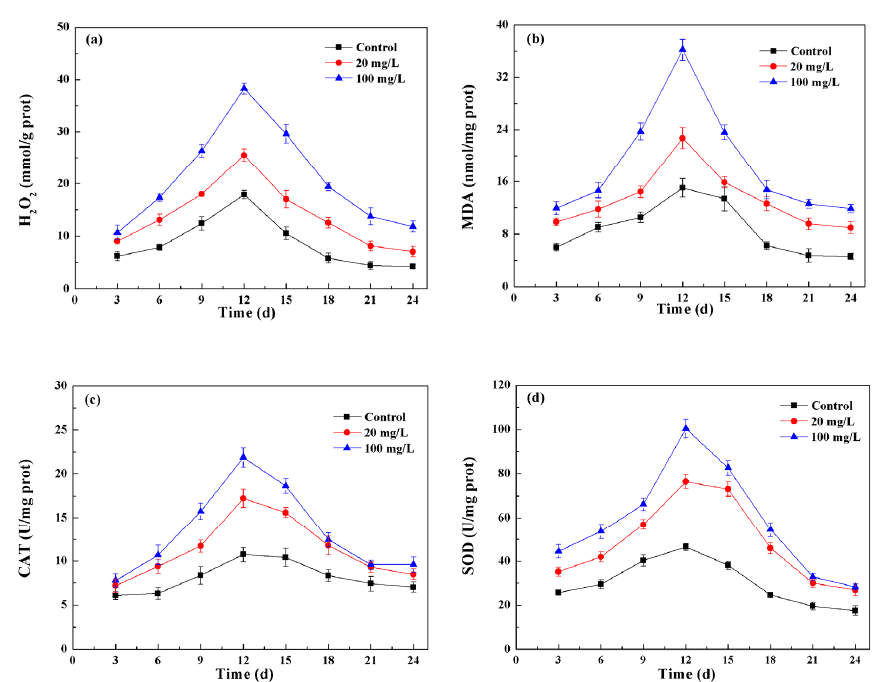
Figure 10. H 2 O 2 ( a ) and MDA ( b ) contents and CAT ( c ) and SOD ( d ) activity of Chlorella sp. UJ-3 exposed to 20 mg/L and 100 mg/L of Fe 3 O 4 NPs during 24 days of cultivation. 3.5. Effects of Low-High Concentration NPs Treatment on Growth and Lipid Accumulation of Chlorella sp. UJ-3 For the Chlorella sp. UJ-3 exposed to 20 mg/L of Fe 3 O 4 NPs, the specific growth rate reached its maximum value on the 12th day (Figure 11). The specific growth rates for algal cell without NPs treatment or with the exposure to 100 mg/L of Fe 3 O 4 NPs also changed with the time course and reached a maximal specific growth rate at a certain time. In ad- dition, the maximal specific growth rate at 20 mg/L of NPs was higher than those without treatment or at 100 mg/L of Fe 3 O 4 NPs (Figure S2). In order to obtain high-yield and high- lipid algae, the algal cells were first exposed to a low concentration of Fe 3 O 4 NPs (20 mg/L) for 12 days, then the concentration of Fe 3 O 4 NPs was increased to 100 mg/L when the spe- cific growth rate reached the maximum. Additionally, the algal cells turned the metabo- lism towards the accumulation of lipids, which allowed large amounts of lipids to accu- mulate, and the total lipid production was approximately doubled compared to the un- treated algal culture (Figure 12). The effect of different transition time on the combination strategy also indicated that low-high transition of Fe 3 O 4 NPs concentration on day 12 pro- vided the best biomass and lipid production (Table S5). This strategy not only ensured the increase in microalgae biomass, but also promoted the accumulation of lipids. The com- position and content of fatty acids are shown in Table 1. The biomass, total lipid content, and total fatty acid production increased by 50%, 42.9%, and 116.7%, respectively, com- pared to the control algal cells (Table 2). Furthermore, the maximum specific growth rate ( μ max ) and maximum lipid productivity (P max ) were also calculated and were found to in- crease by 23.1% and 133.5%, respectively, compared with the control (Table 2). The results showed that this strategy is effective and useful for high lipid production by Chlorella sp. UJ-3.